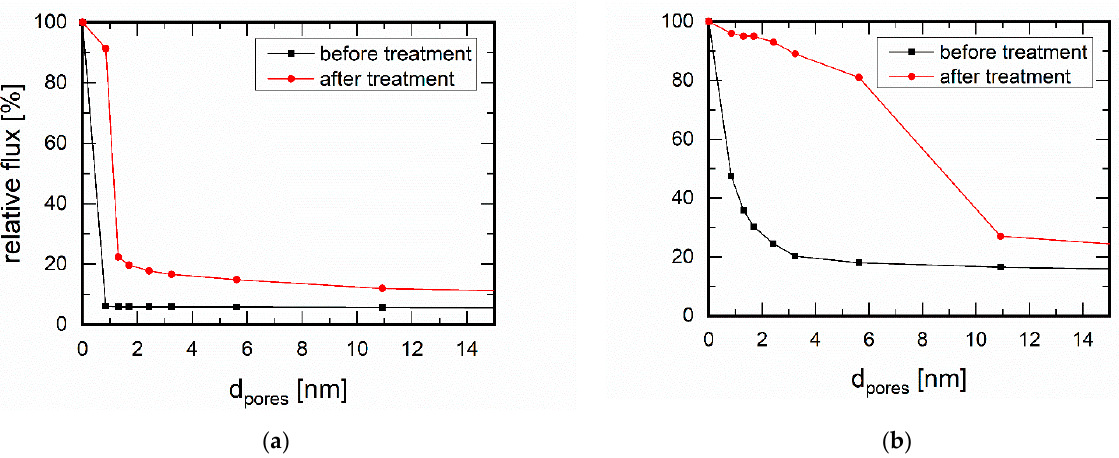
Figure 3. Permporometry measurements on ( a ) an MFI membrane and ( b ) a silica membrane (d pore = 1 nm) before and after amine treatment (2.97 g/L piperazine and 5.15 g/L diethanolamine for 7 days), measured with N 2 as the inert gas and n-hexane as the condensable component.